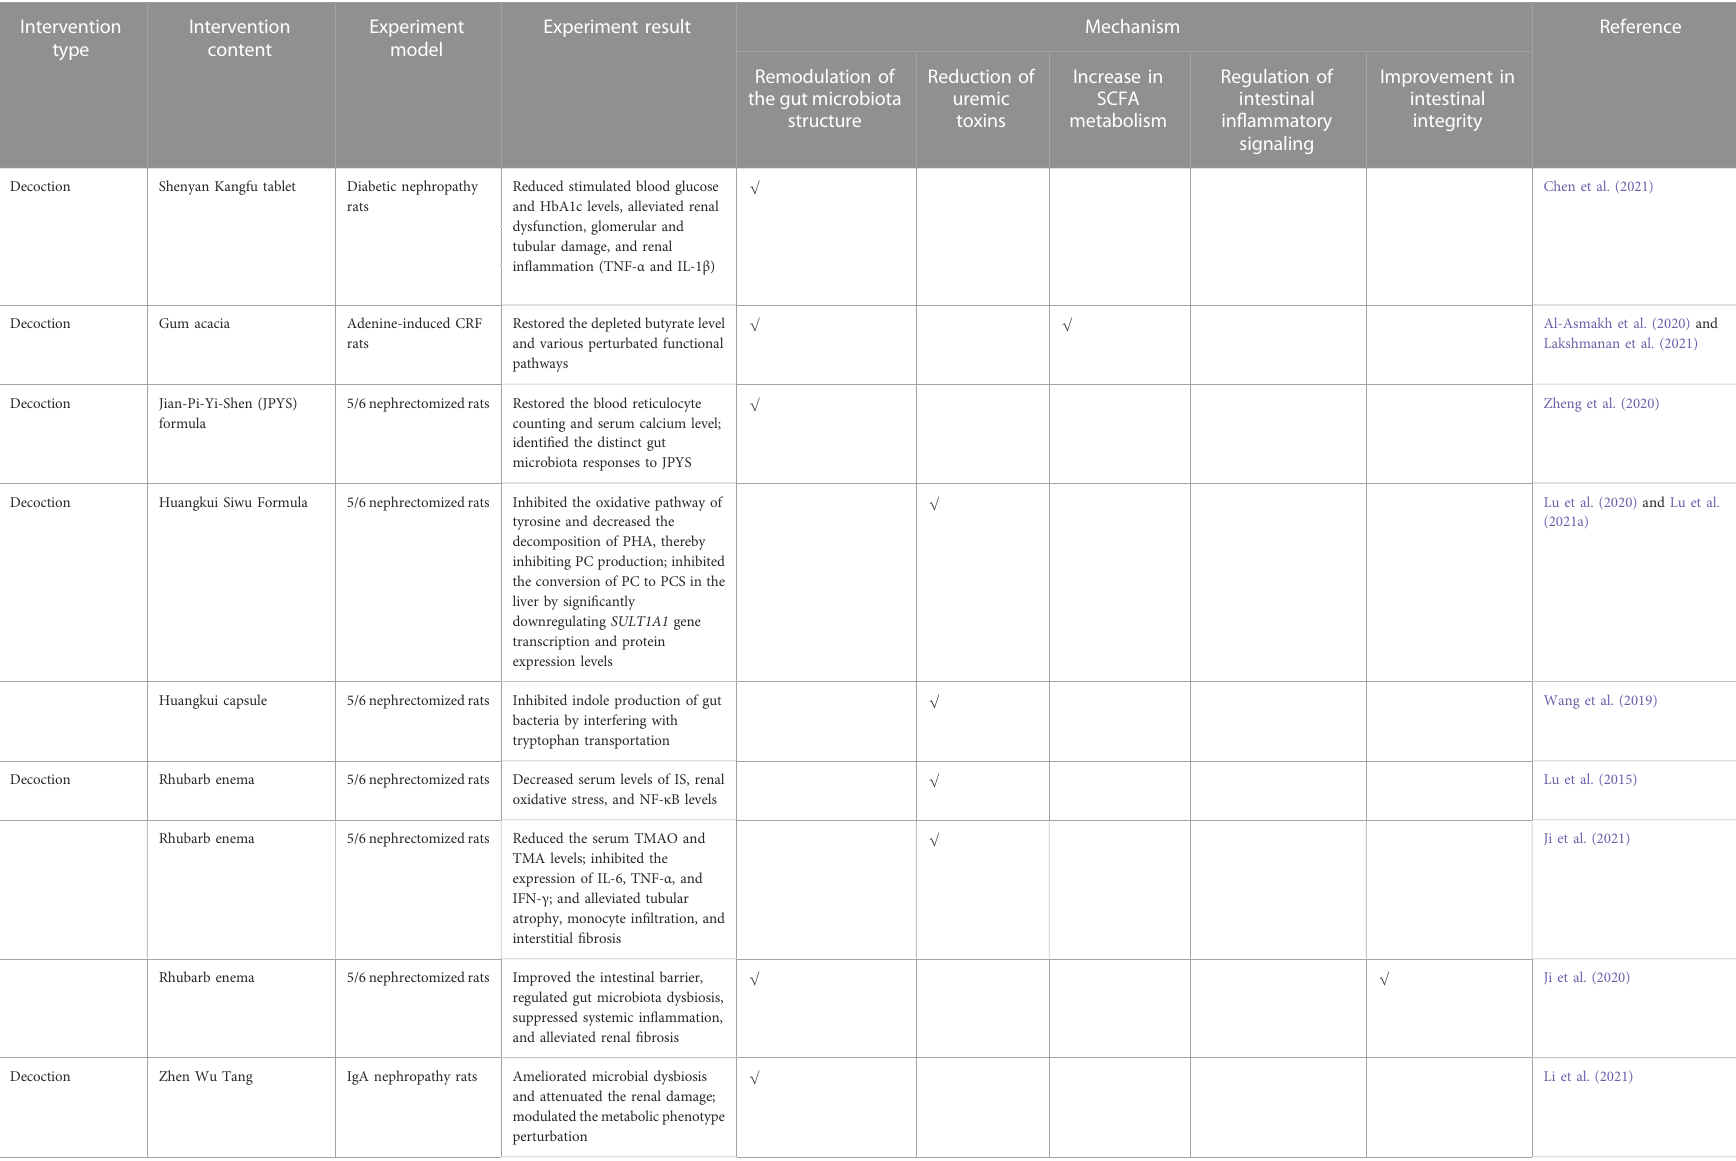
TABLE 1 Mechanisms of gut microbiota as an alternative target for natural products from plants and microorganisms for the treatment of CKD in animal